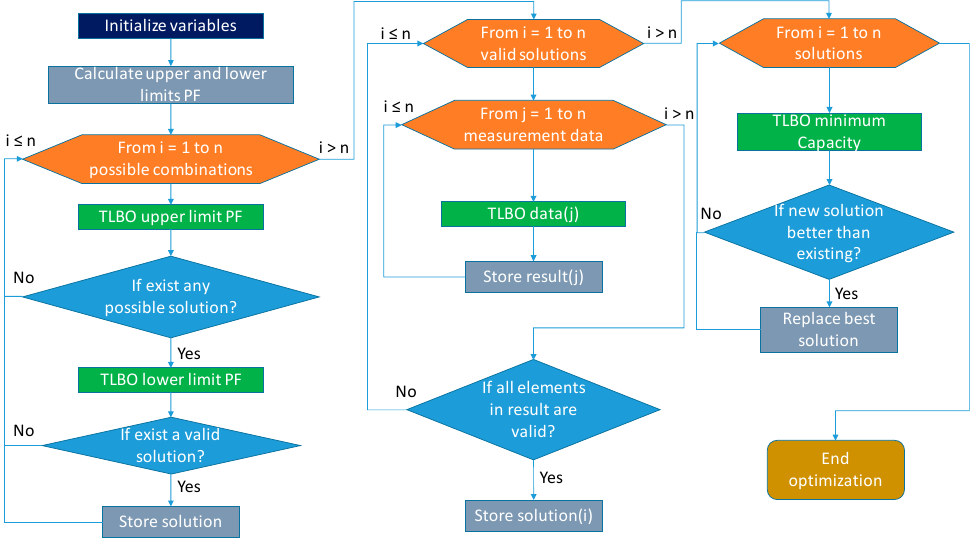
Figure 2. Flow chart of the capacitor bank optimization (CBO) Algorithm.